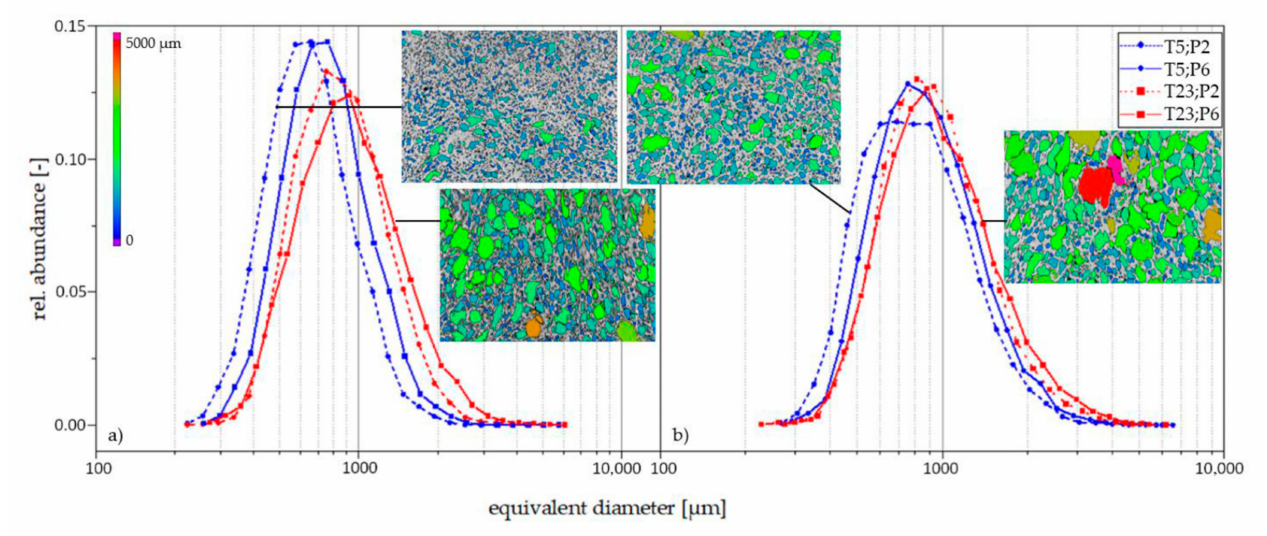
Figure 6. Relative abundance of the equivalent diameter (( a )—W34; ( b )—W48) for non-degassed samples